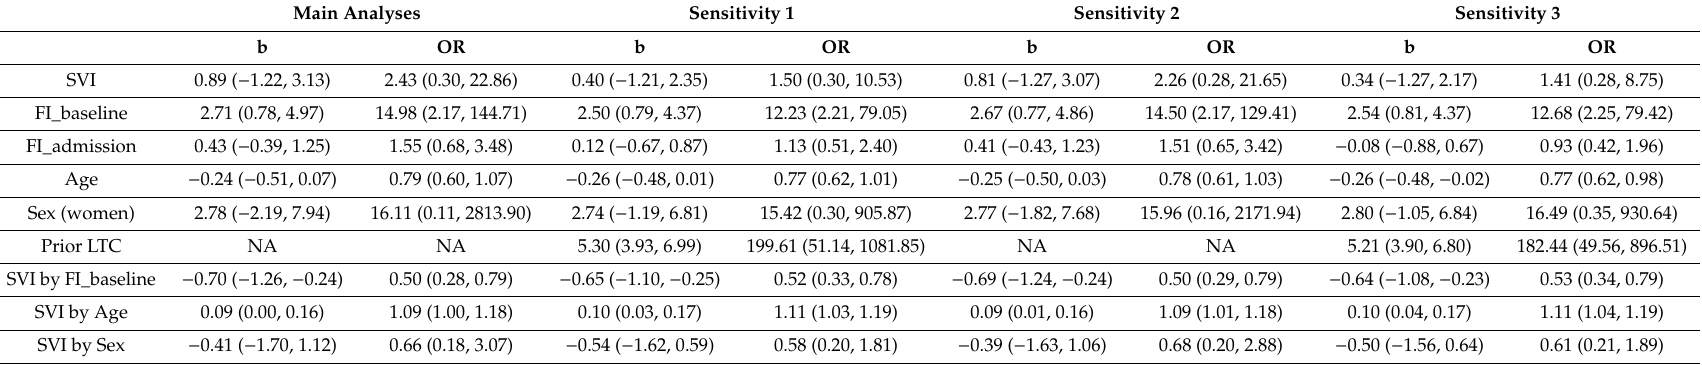
Table 3. Coe ffi cients (b) and odds ratios (OR) plus 95% confidence intervals (CI) from the logistic regression results for the main and sensitivity